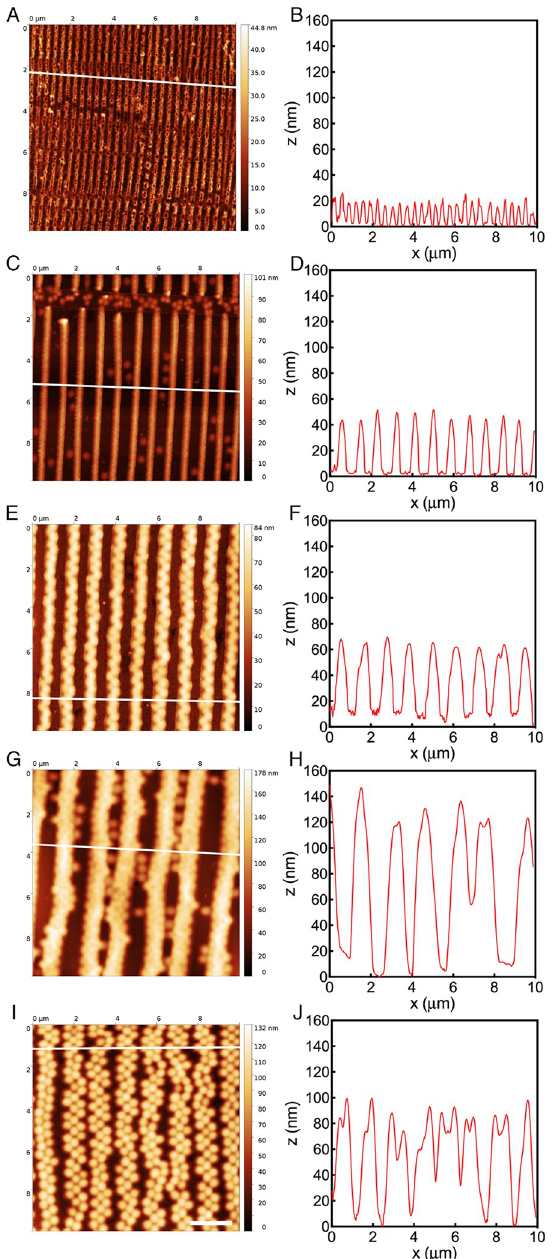
Fig 2. Atomic force microscopy analysis of microgel array topography. Representative atomic force microscopy images and their plot profiles of microgel arrays printed on glass coverslips at a spacing of 300 (A, B), 800 (C, D), 1200 (E, F), 1600 (G, H) nm and 5mol% (I, J) after 48 hours incubation in water. The legend on the side of each AFM image indicates the height of the arrays. White lines in the AFM images indicate the positions from which the plot profiles were generated. Scale bar: 2 μ m. Note that microgel height increased by increasing array spacing and that swelling of 300 nm arrays reduced their lateral resolution causing a partial merging of adjacent arrays. The heterogeneities visible in A and C are due to the manufacturing process and do not affect the performance of the printed microgel arrays.